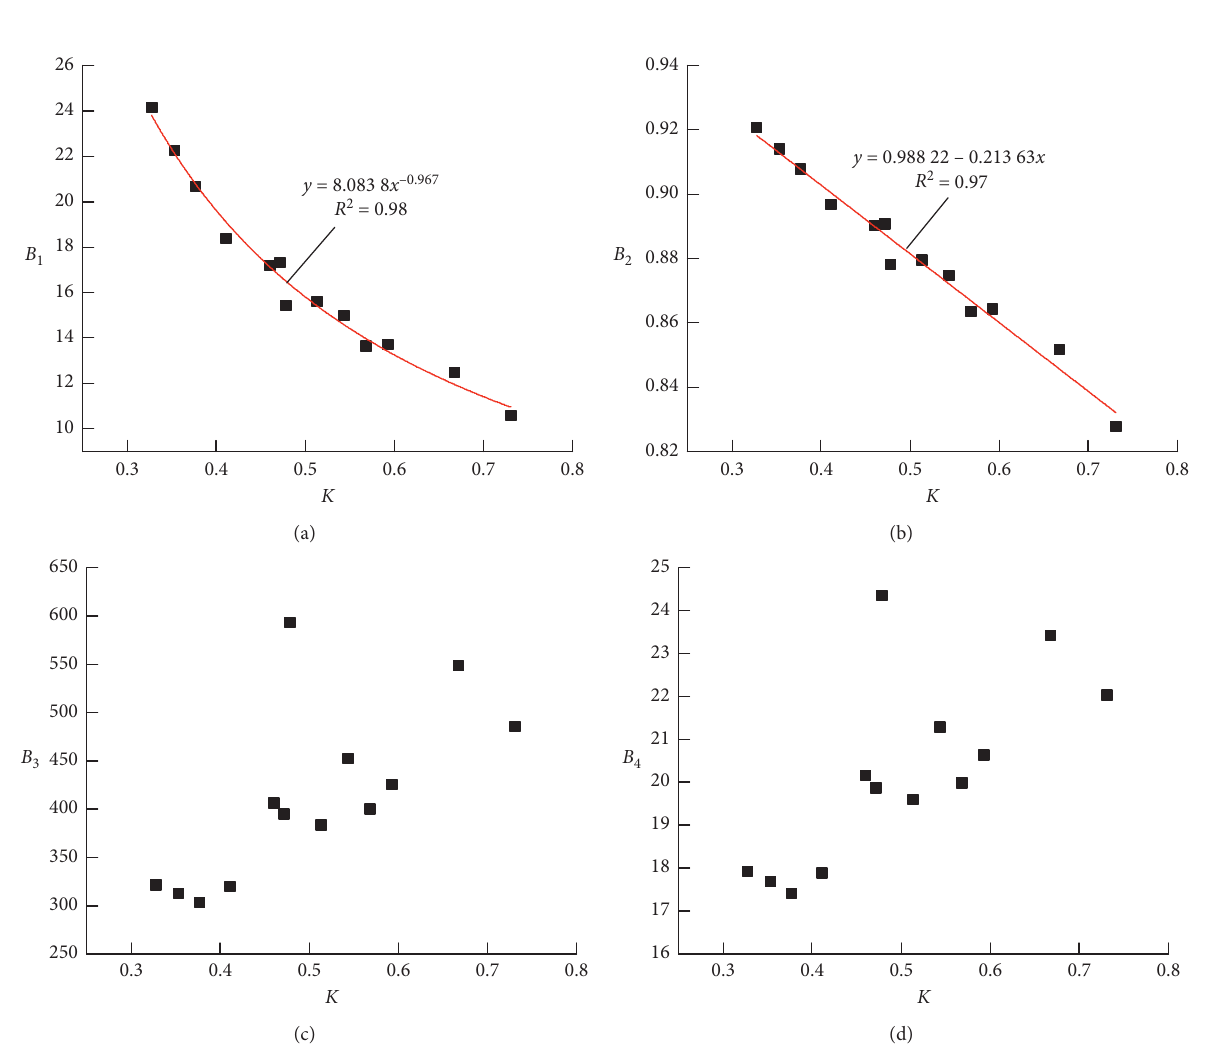
Figure 3: Relationship between crack initiation stress ratio K of granite and different brittleness indexes: (a) B